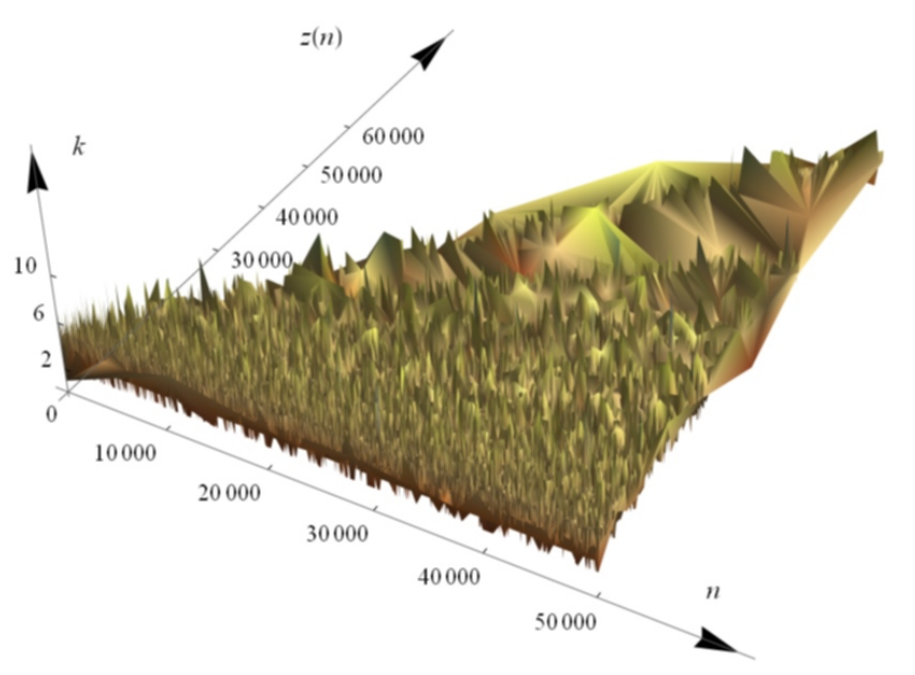
Figure 3. The graph of points [ n , z ( n ) ,#Orb z ( n )] in a phase space for n from 1 to